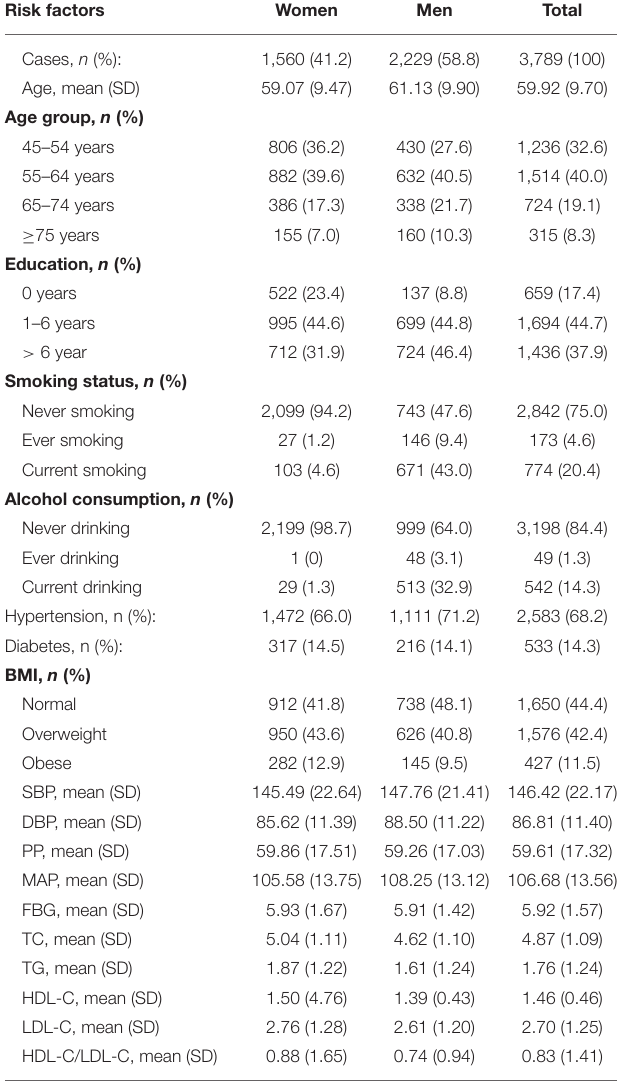
TABLE 1 | Demographic characteristics and risk factors for all